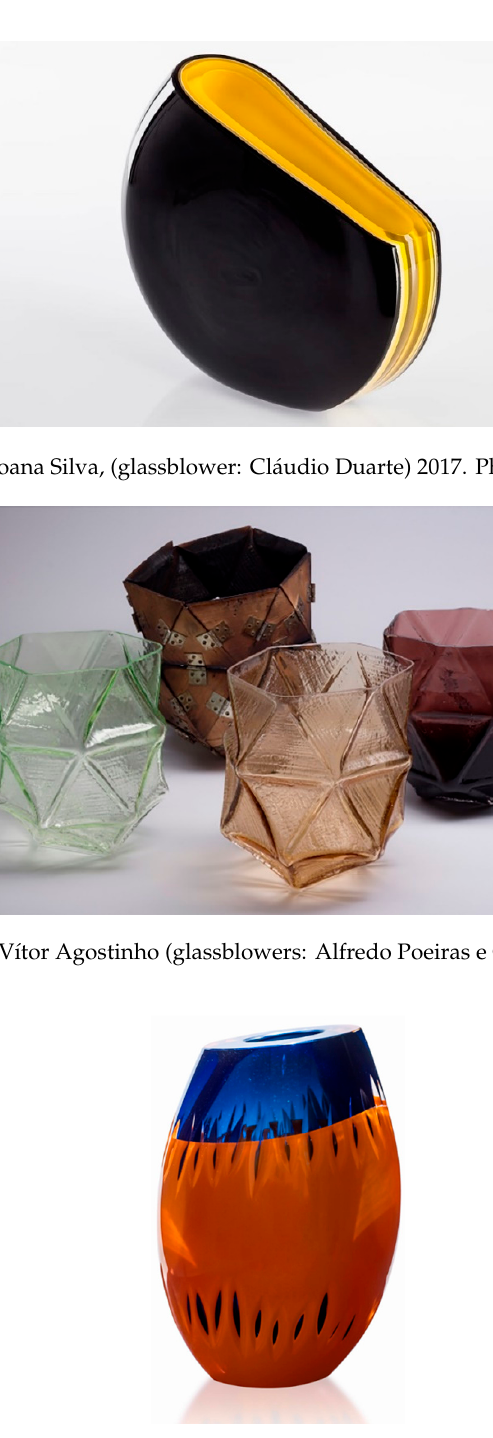
Figure 12. Multicolored , Nelson Figueiredo, 2018. Photo credit: the designer.